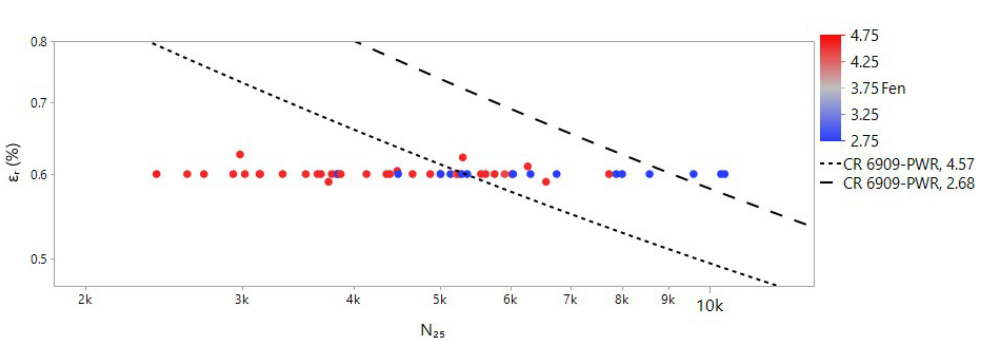
Figure 6. Data in the low F en programme; the reference curves are calculated from the NUREG/CR- 6909 mean air curve and the two F en values considered